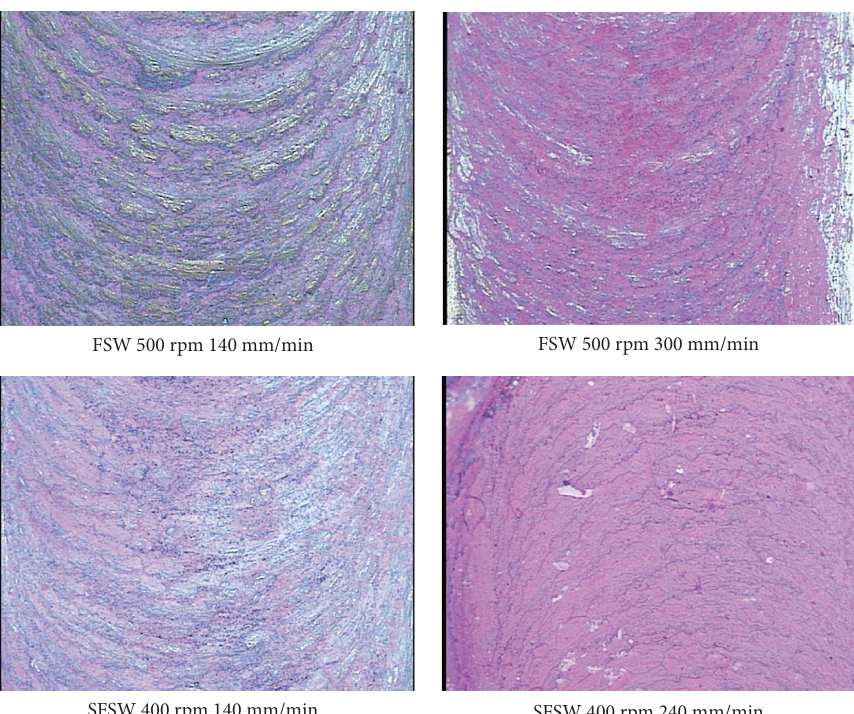
Figure 11: Dye penetrant test images of the welded joints.